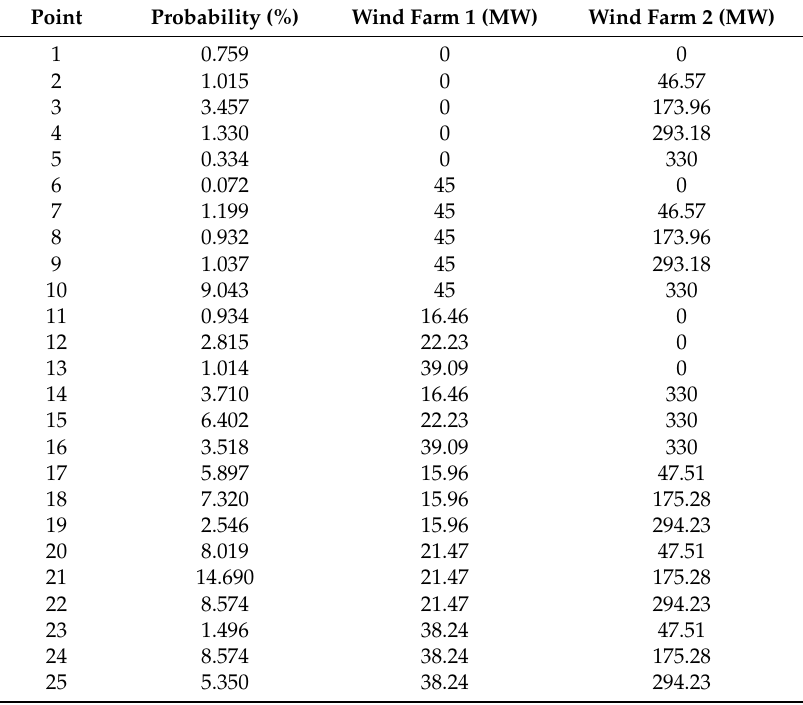
Table 2. Probability of multi-correlated wind